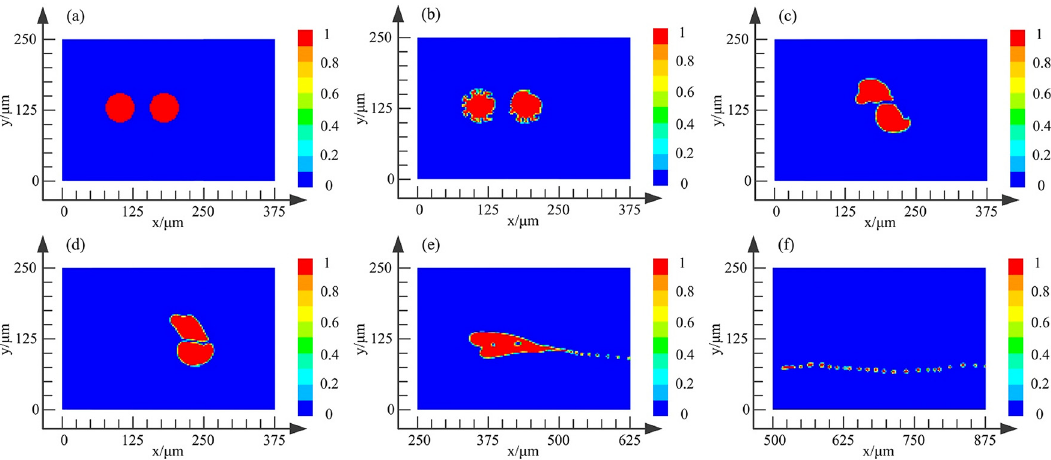
Figure 10. Volume fraction profiles of the double parallel bubbles bursting process: ( a ) t = 0 µ s, ( b ) t = 10 µ s, ( c ) t = 130 µ s, ( d ) t = 160 µ s, ( e ) t = 250 µ s, ( f ) t = 300 µ s.